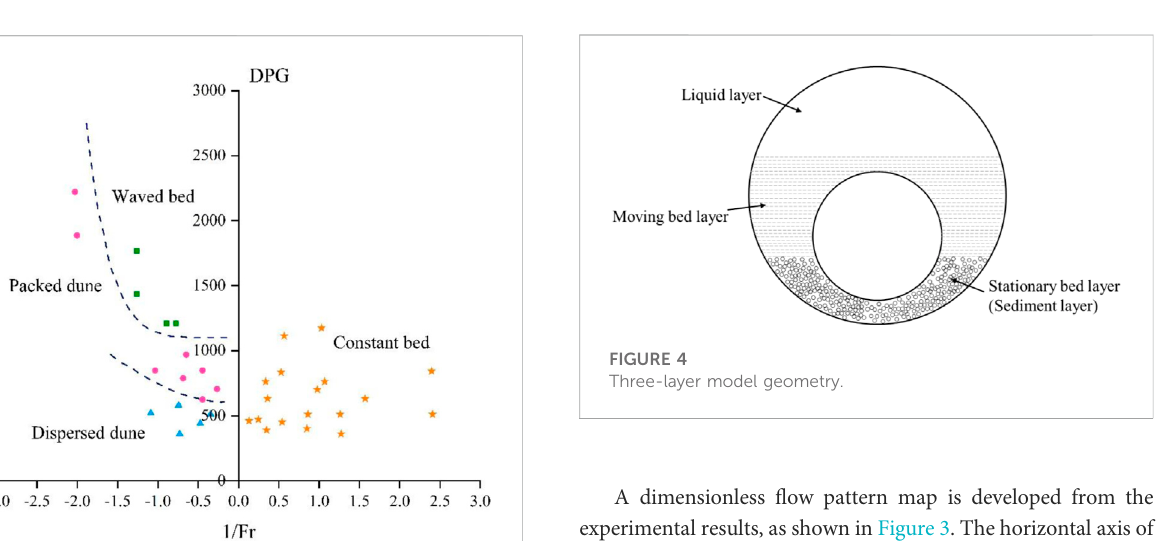
FIGURE 3 Flow pattern map (Zhang et al., 2015).